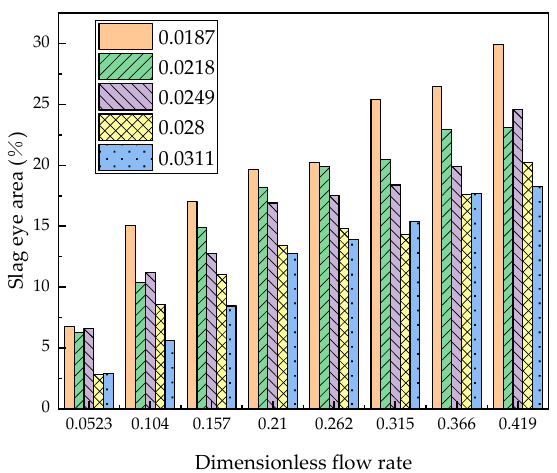
Figure 12. The areas of slag eye at different flow rates and oil thickness in water model with single porous plug.